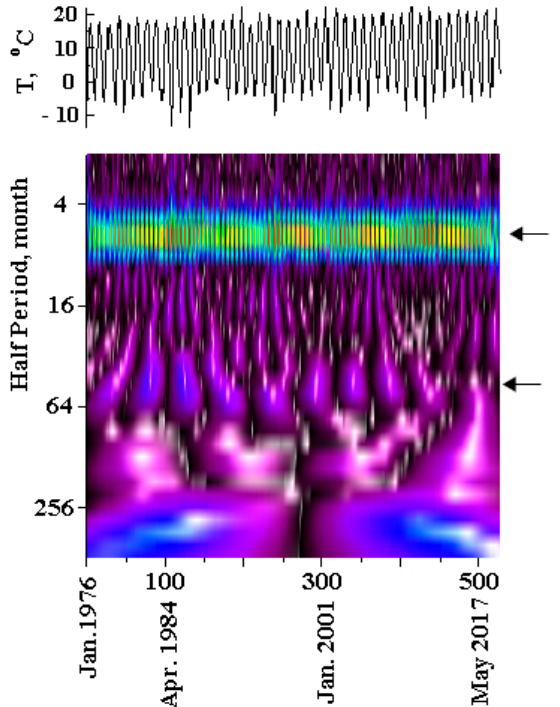
Figure 13. Wavelet-periodogram of long-term (1976–2019) observations of temperature cyclicity (monthly amount) at Khmilnyk city. Cyclicity periods: top arrow—1 year, lower arrow—8 years.